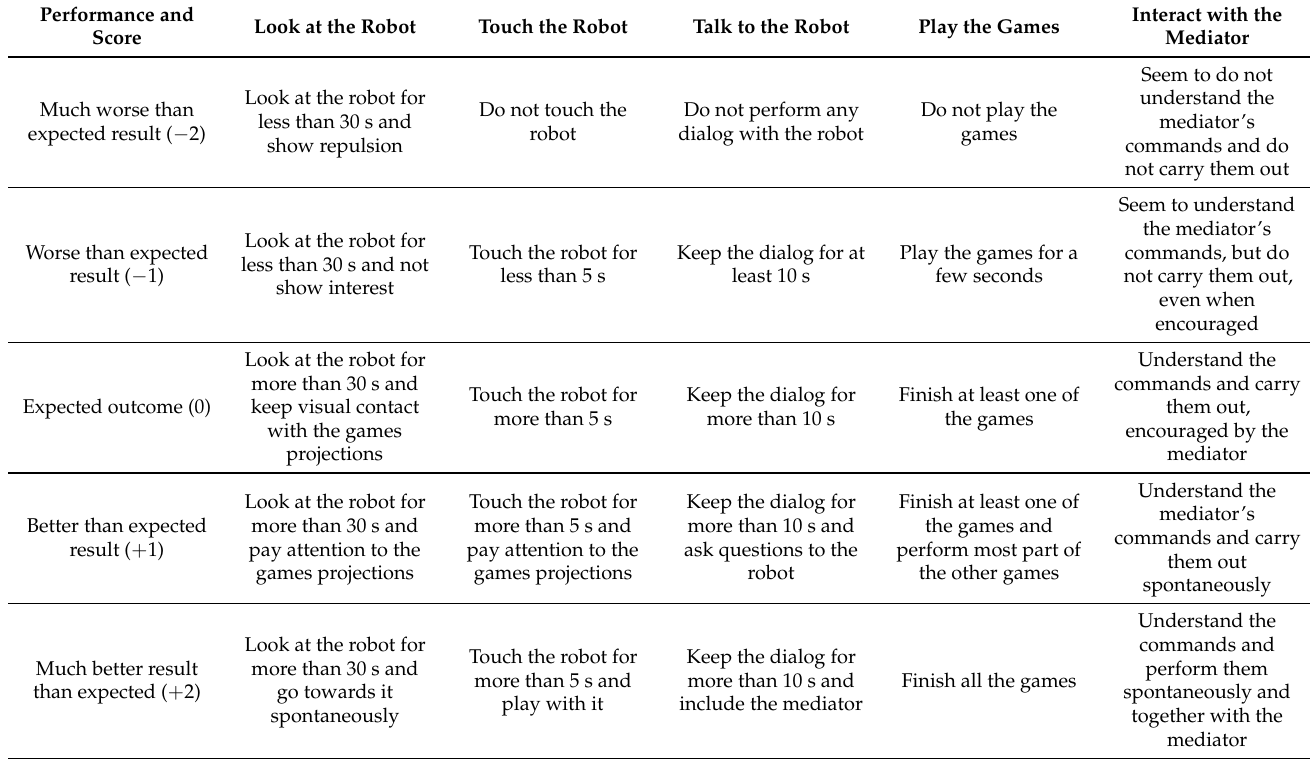
Table 1. GAS method for the five objectives of the experiment.